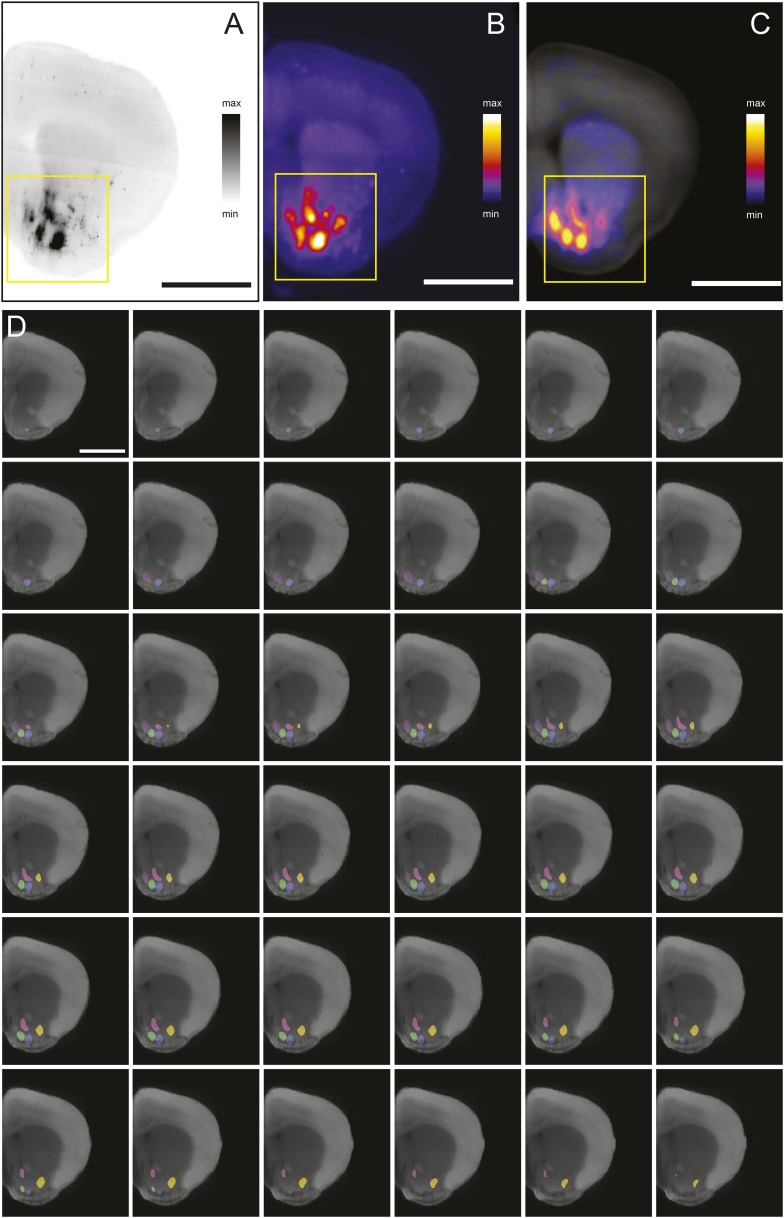
Density-based analysis of inputs to projection-specified dopamine neurons.All neurons from all animals were plotted in a reference space with 20 μm × 20 μm × 20 μm voxels, and a 3D Gaussian with kernel size of 60 μm × 60 μm × 60 μm was used to estimate density at each voxel. (A) A typical optical coronal section of raw fluorescence containing the ventral striatum colored such that black indicates fluorescence. (B) Average fluorescence among all animals displayed as a heat map. (C) Density estimate based on Gaussian smoothing of the image generated by plotting all extracted centroids from all animals displayed as a heat map. (D) A series of coronal sections demonstrating the 3D structure of the patches, obtained by finding the local maxima from C and expanding stepwise pixel-by-pixel until either 1/3 maximum intensity or another patch boundary was reached. Patch coloring matches Figure 7. Bars represent 2 mm.